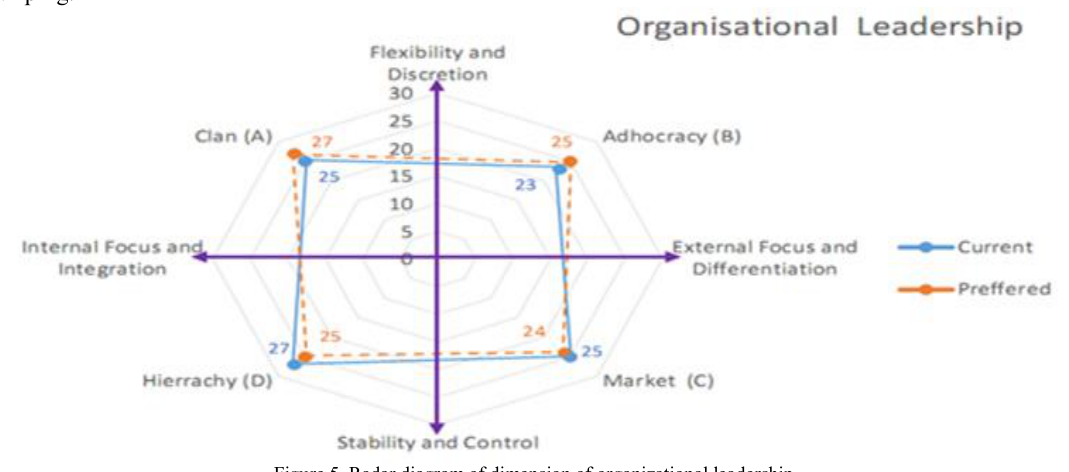
Figure 5. Radar diagram of dimension of organizational